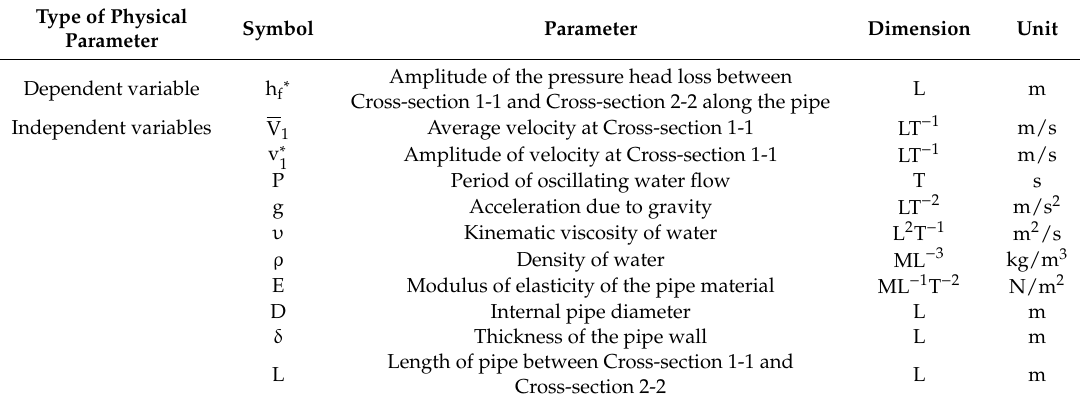
Table 2. Physical parameters that a ff ect the amplitude of the pressure head loss of oscillating water flow. Type of Physical Symbol Parameter Dimension Unit Parameter Amplitude of the pressure head loss between Dependent variable h f ∗ Cross-section 1-1 and Cross-section 2-2 along the pipe